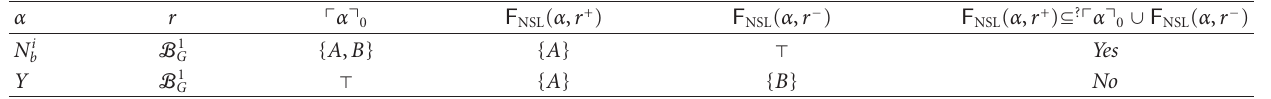
Table 12: Analysis of NSL protocol: role of B.